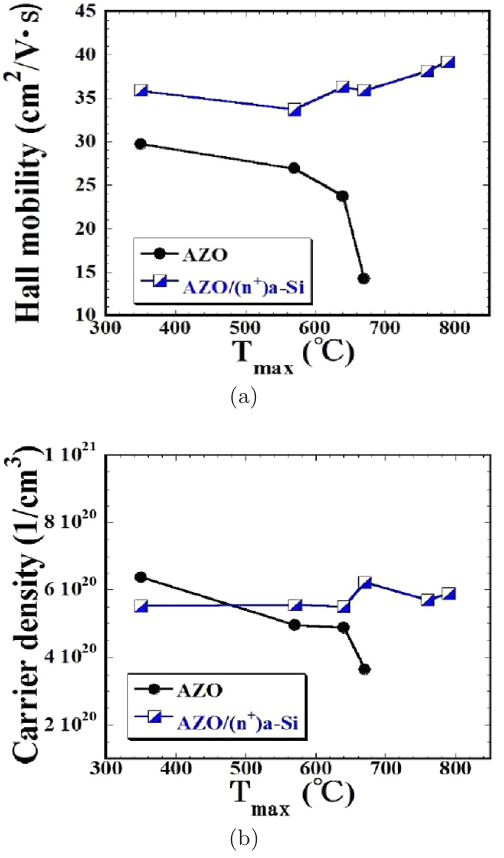
Fig. 2. (a) Hall mobility µ and (b) carrier density N e of TPJ- annealed AZO films at different T max s. The n + -Si layer on top of AZO was etched out using reactive ion etching after TPJ annealing. The TPJ annealing was performed by changing v sub from 55 to 22